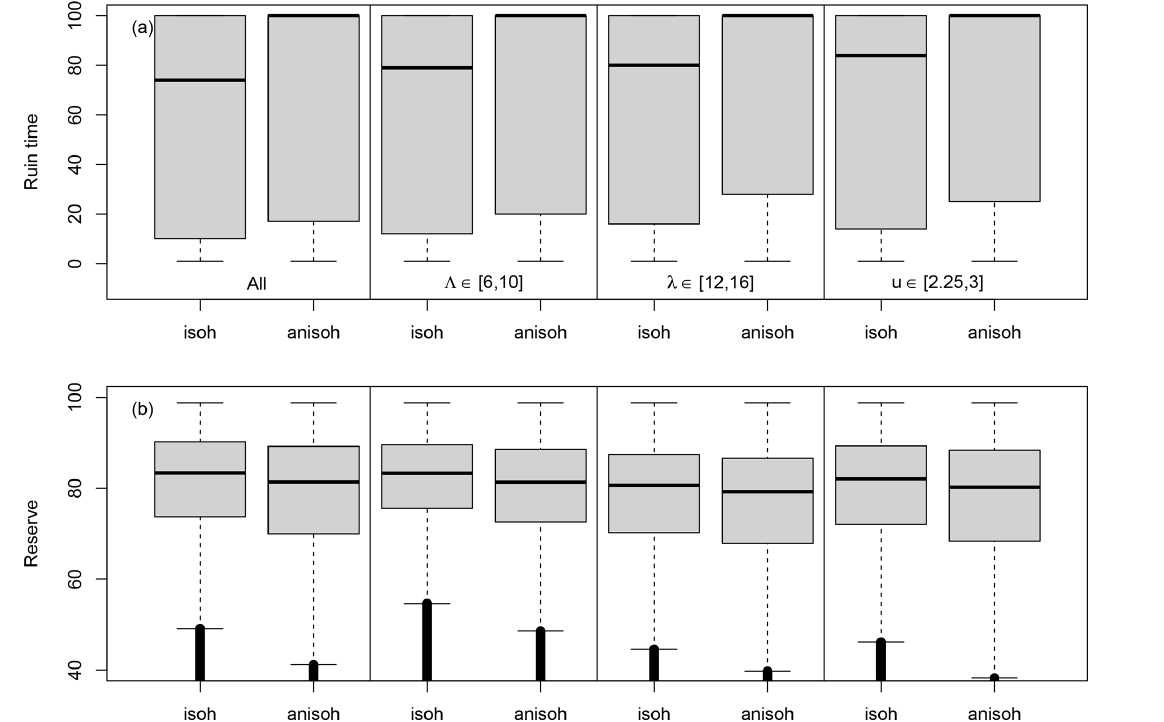
Figure 5. Conditional probability distributions of the ruin time (a) and the reserve (b) . The boxplots in the first column (isohydric (isoh: B = 0) and anisohydric (anisoh: B = 0 . 4)) are for all simulations. The boxplots in the second column are for drought–heatwave return periods ( (cid:51) ) of 6–10 years in the isohydric (isoh) and anisohydric (anisoh) simulations. The boxplots in the third column are for drought–heatwave durations during summer ( λ ) of 12–16d. The boxplots in the last column are for GPD thresholds of 2.25–3. Data that are below the whiskers are shown as small circles; these circles are close to each other and therefore appear like thick vertical